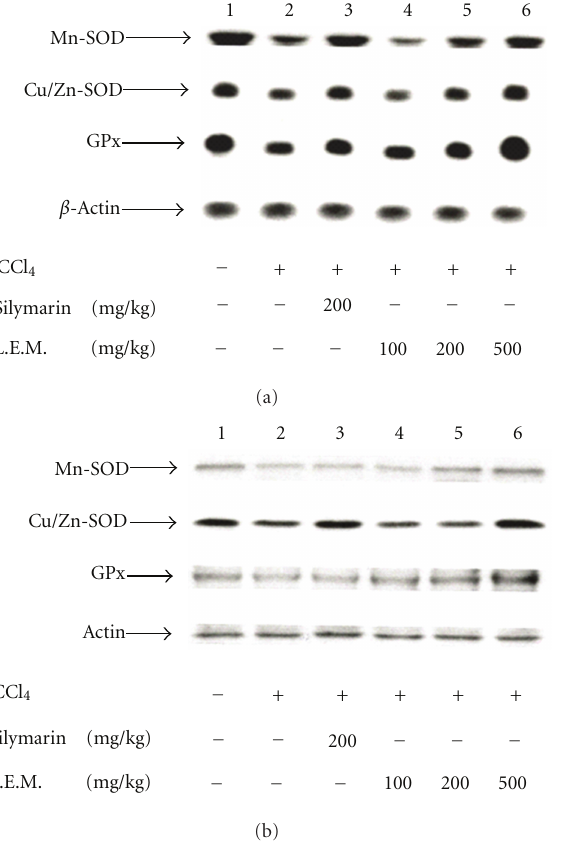
Figure 4: E ff ects of LEM on gene expressions of Mn-SOD, Cu/Zn- SOD, and glutathione peroxidase (GPx) in liver of CCl 4 -treated rats. (a) The representative picture showing mRNA levels for Mn- SOD, Cu/Zn-SOD, GPx, or β -actin in liver isolated from CCl 4 - induced rats receiving treatment with silymarin or LEM three times daily for 8 weeks. Lane 1: vehicle-treated Wistar rats; lane 2: vehicle-treated CCl 4 -induced rats; lane 3: silymarin- (200mg/kg) treated CCl 4 -induced rats; lane 4: LEM- (100mg/kg) treated CCl 4 - induced rats; lane 5: LEM- (200mg/kg) treated CCl 4 -induced rats; lane 6: LEM- (500mg/kg) treated CCl 4 -induced rats. (b) The representative response of protein level for Mn-SOD, Cu/Zn-SOD, GPx, or actin in liver isolated from CCl 4 -induced rats receiving treatment with silymarin or LEM three times daily for 8 weeks. All lanes are expressed as the same as mRNA level (a) on the above.